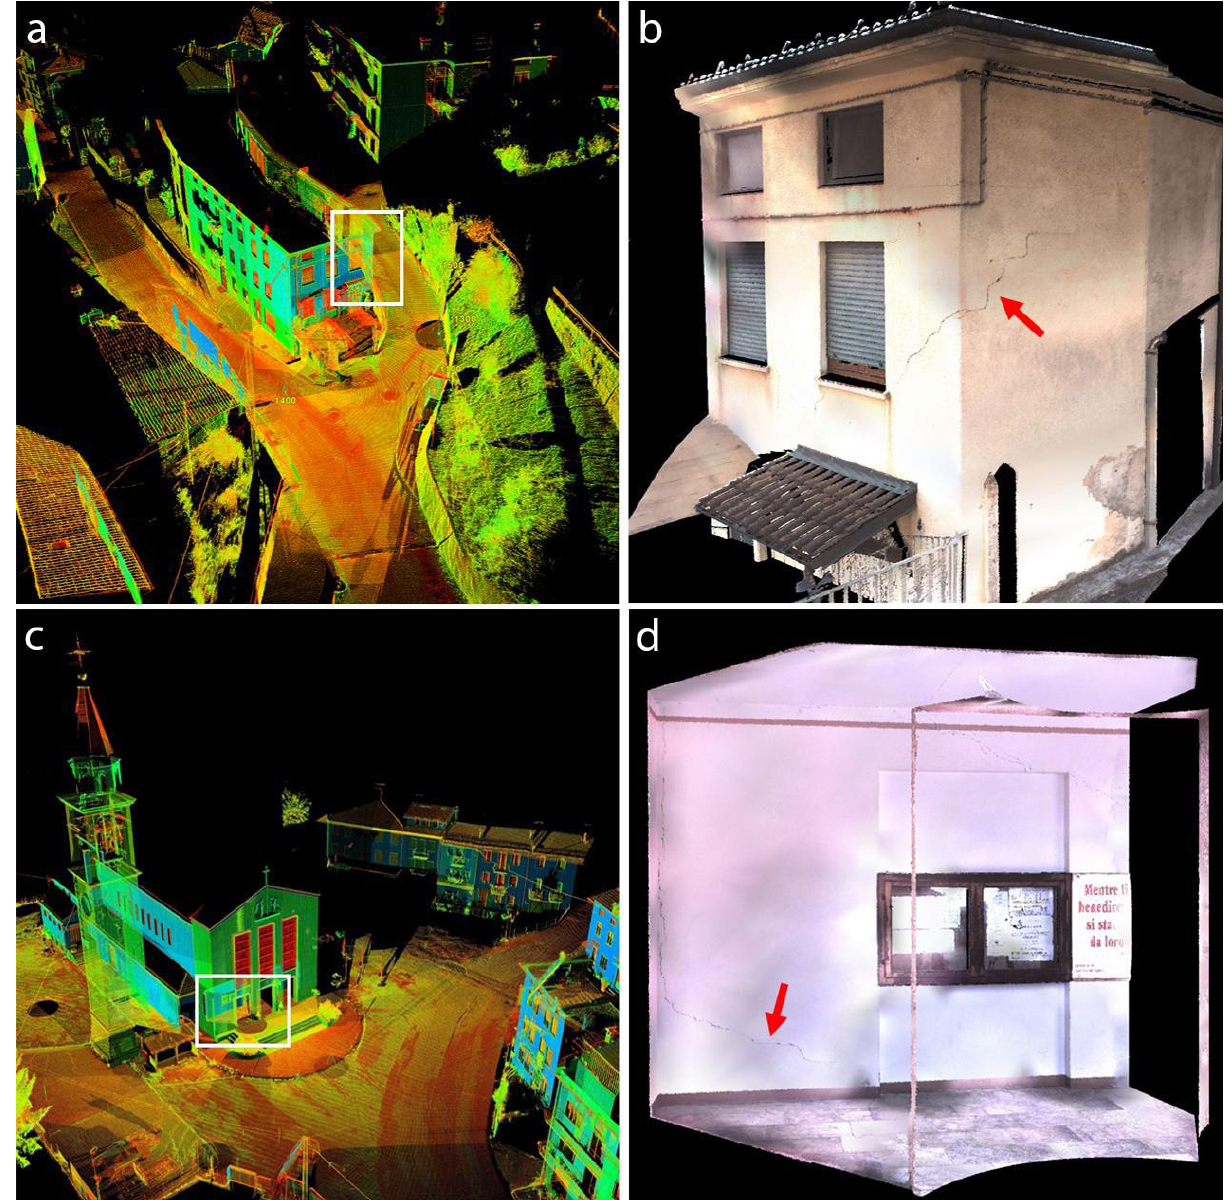
Figure 10. Point cloud perspective view of the damaged building located in Cappellazzi district ( a ) and of Rovegliana Church ( c ) derived by TLS. White squares indicate the portions affected by cracks ( b , d ).